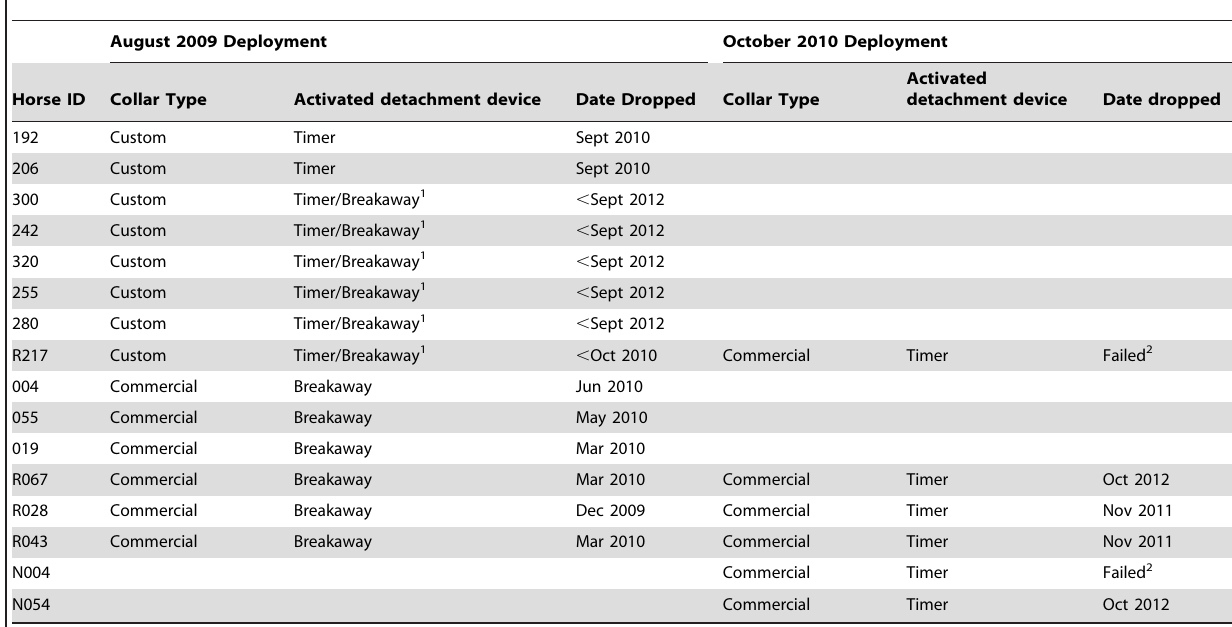
Table 2. Type of collar, type of detachment device, and date dropped for VHF/GPS collars deployed on free-roaming horses in 2009 and 2010, Sheldon National Wildlife Refuge,